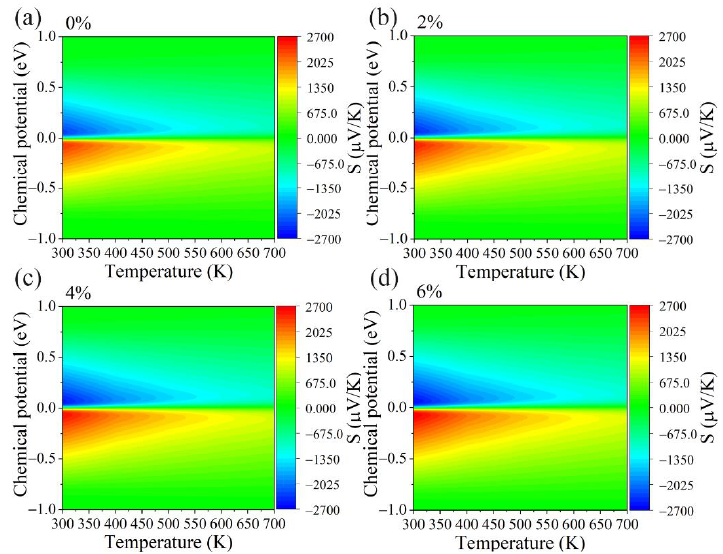
Figure 4. The contour maps of the Seebeck coefficient S with respect to chemical potential under different biaxial tensile strains of ( a ) 0%, ( b ) 2%, ( c ) 4% and ( d ) 6% for GeS 2 monolayer.